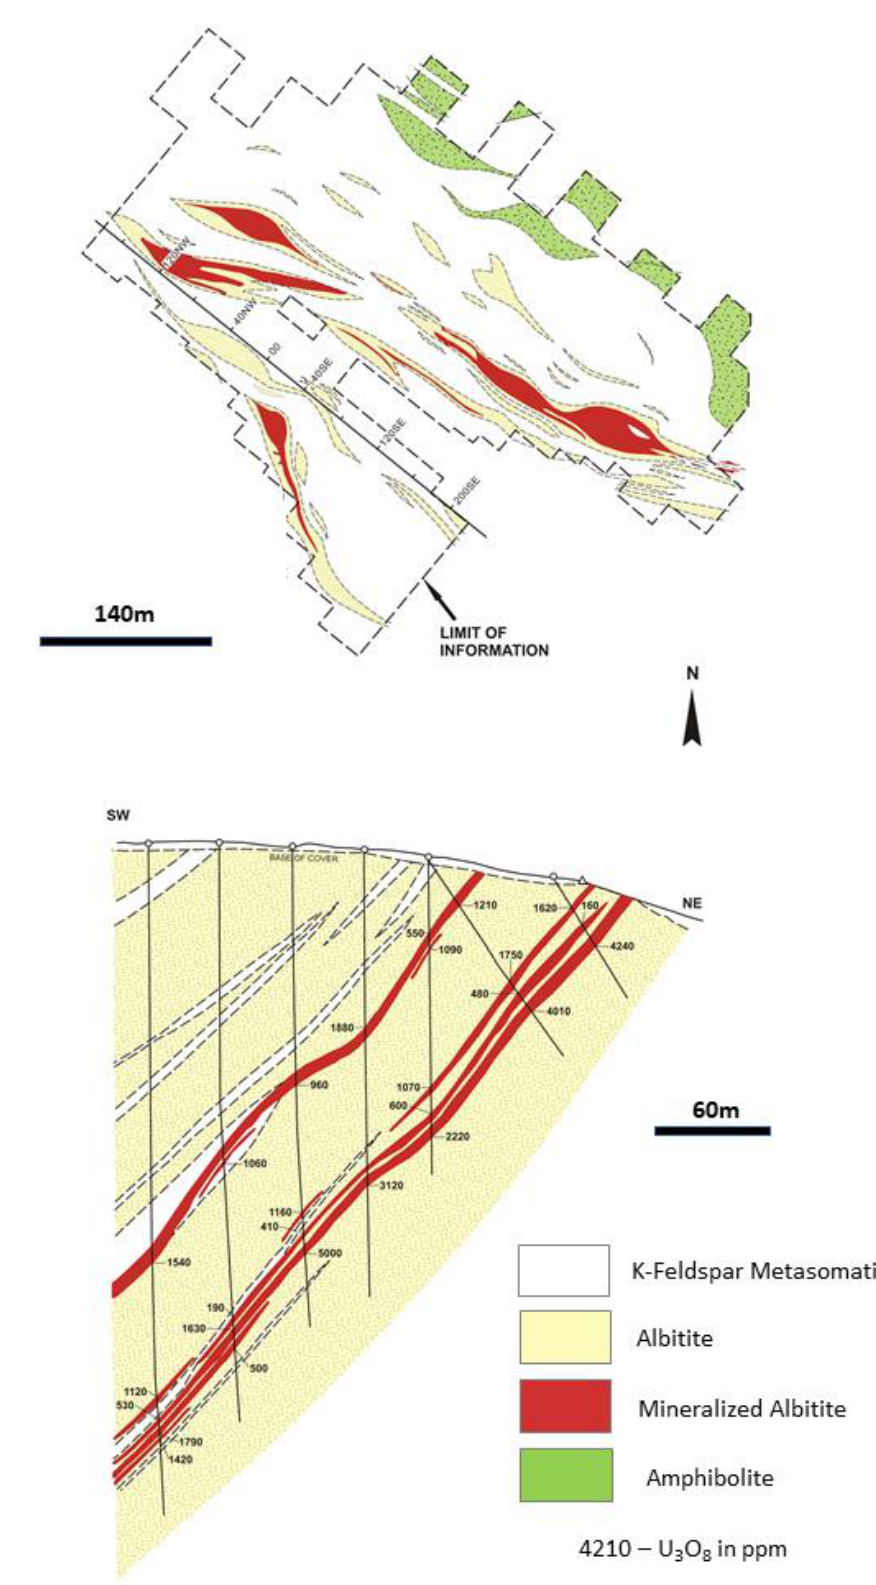
Figure 5. ( A )—plan view of the Cachoeira deposit, Lagoa Real district. ( B )—section from the Rabicha Figure 5. ( A ) — plan view of the Cachoeira deposit, Lagoa Real district. ( B ) — section from the Rabicha deposit, Lagoa Real District. From de Oliveira et al., deposit, Lagoa Real District. From de Oliveira et al., 1985.